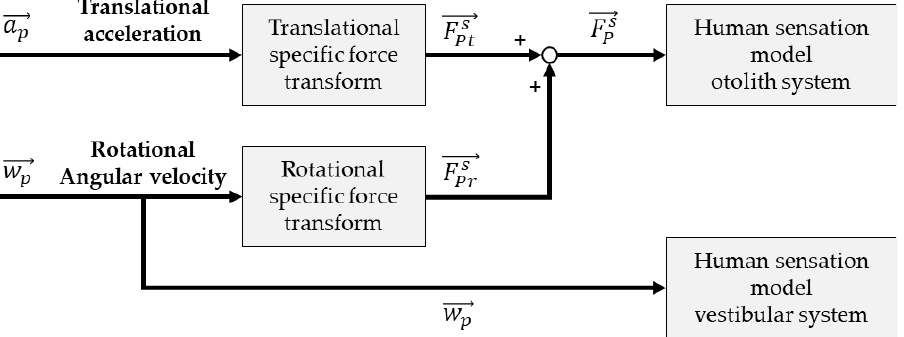
Figure 11. Simulation diagram for the motion sensation in actual vehicle.